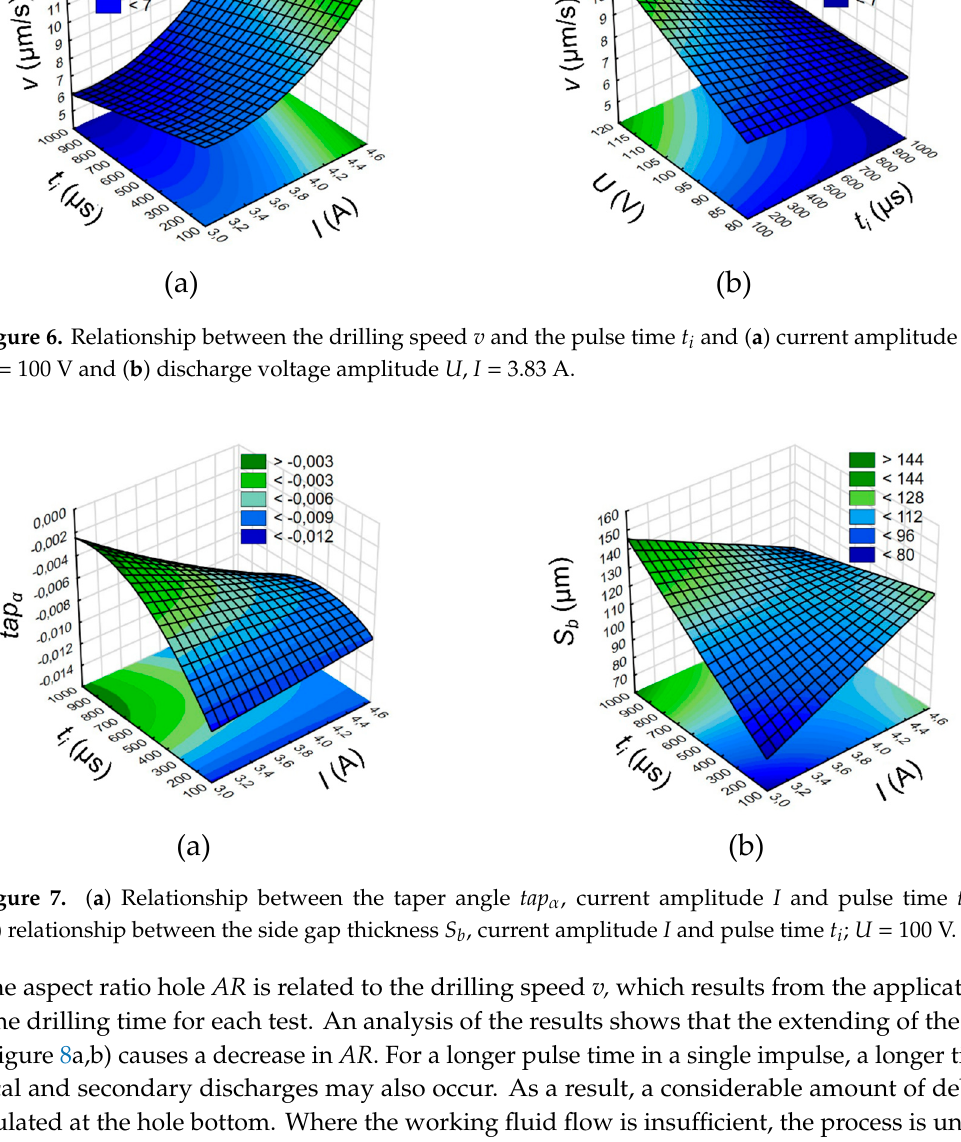
(b) Figure 8. ( a ) Relationship between the aspect ratio AR and the pulse time t i and ( a ) discharge voltage amplitude U , I = 3.83 A and ( b ) current amplitude I , U = 100 V. 3.2. Results Analysis of the Working Fluid Flow in the Electrode Channel